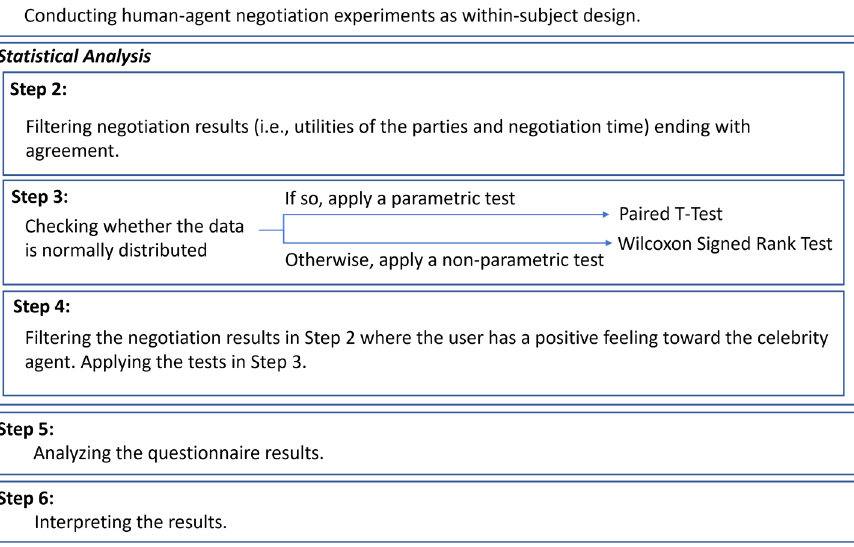
Figure 4. Empirical Research Road Map.